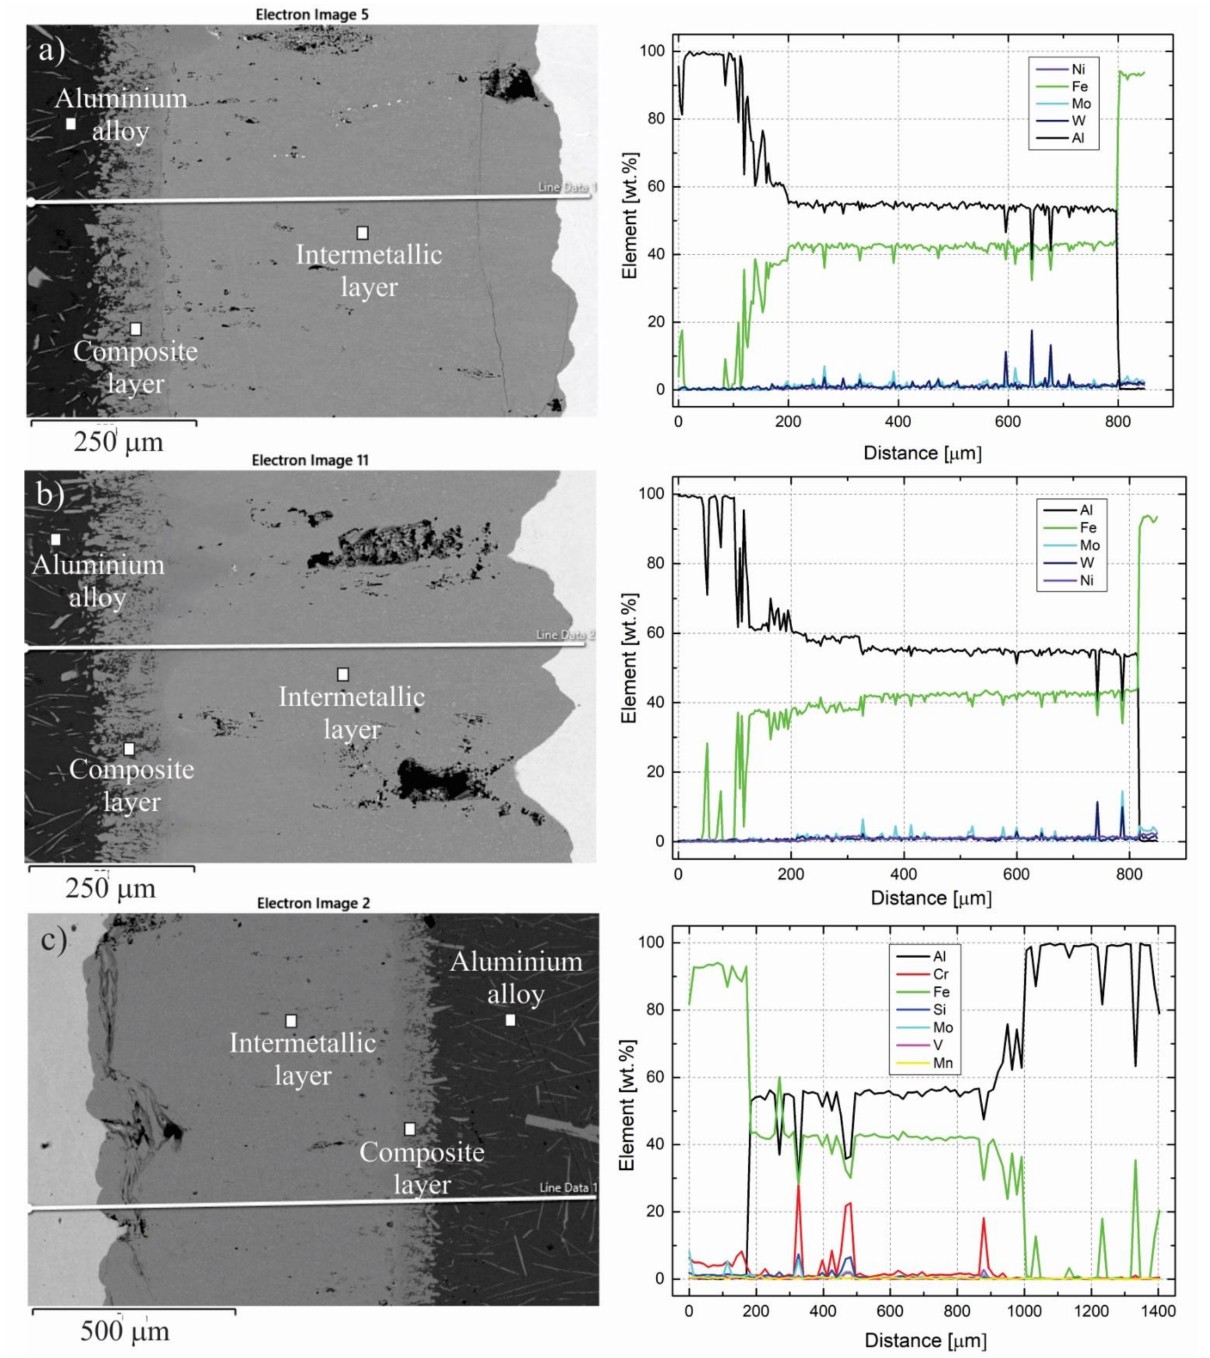
Figure 9. EDS line-scan analyses across the interface between W600 ( a ), HTCS-130 ( b ), and UTOPMO1 ( c ) tool steel and Al99.7 aluminum